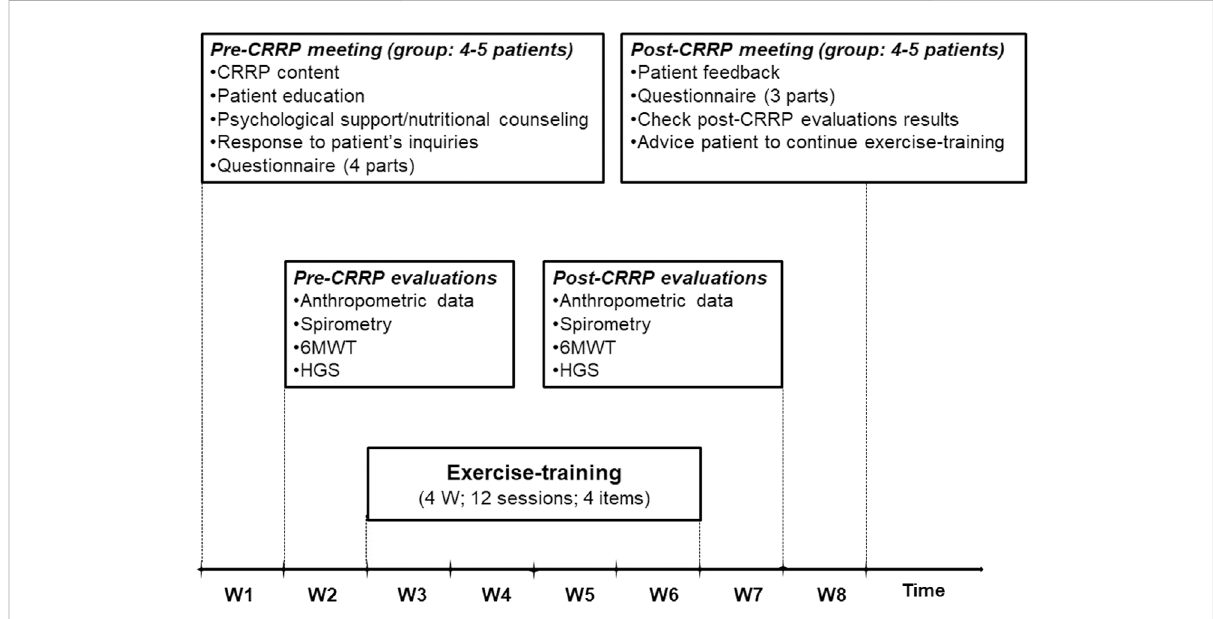
FIGURE 2 Cardiorespiratory rehabilitation program (CRRP). HGS, handgrip strength; W, week; 6MWT, 6-min walk